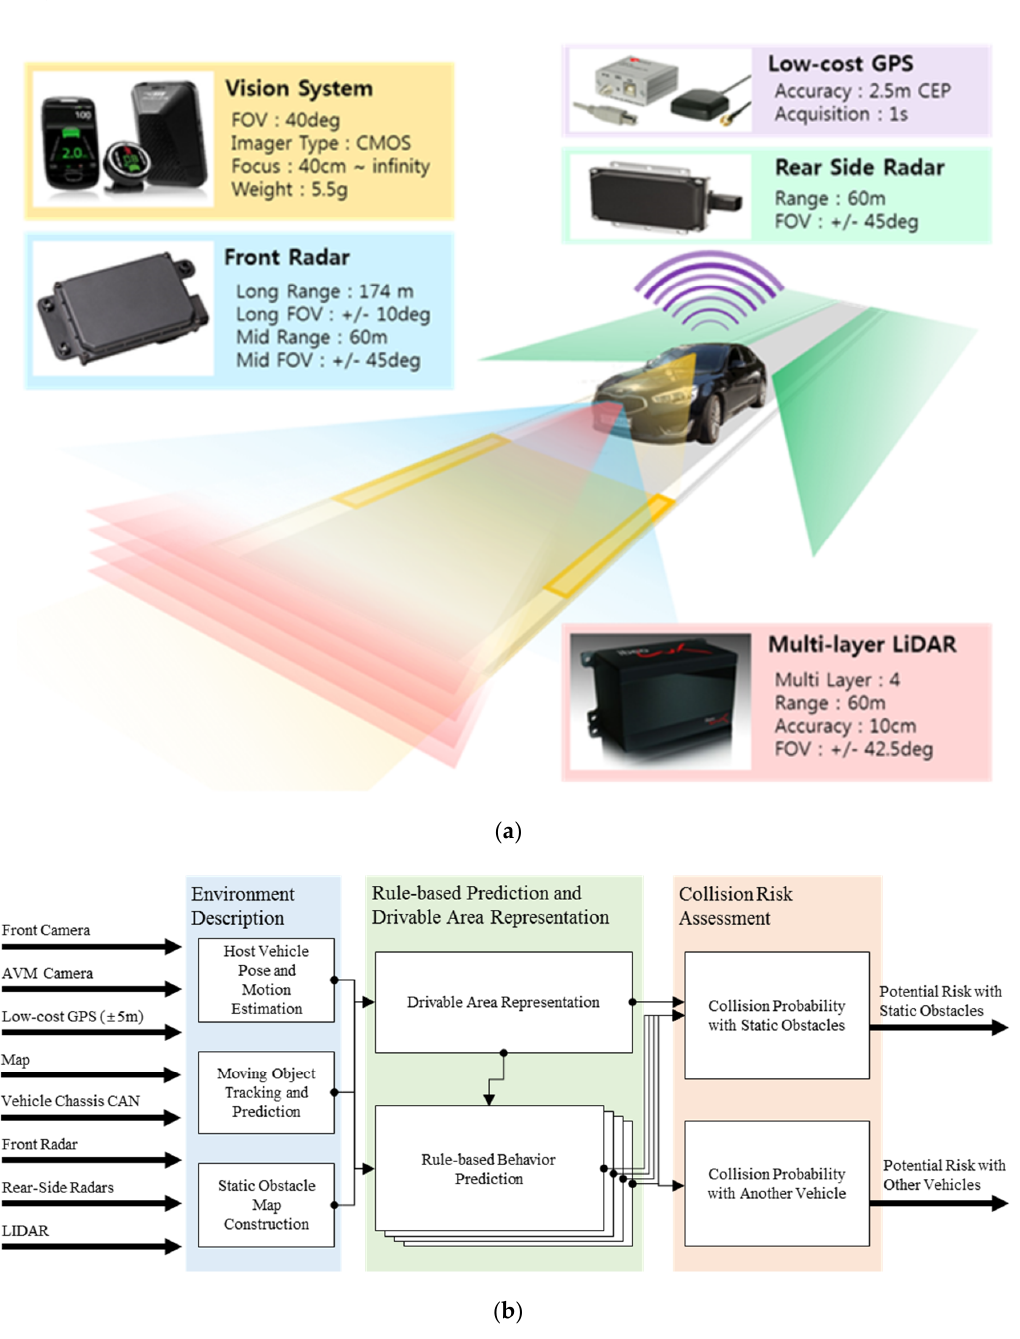
Figure 1. The experimental vehicle with sensor setup and architecture of a human-centered risk assessment. ( a ) Sensor configuration of test vehicle; ( b ) Architecture of human-centered threat assessment.